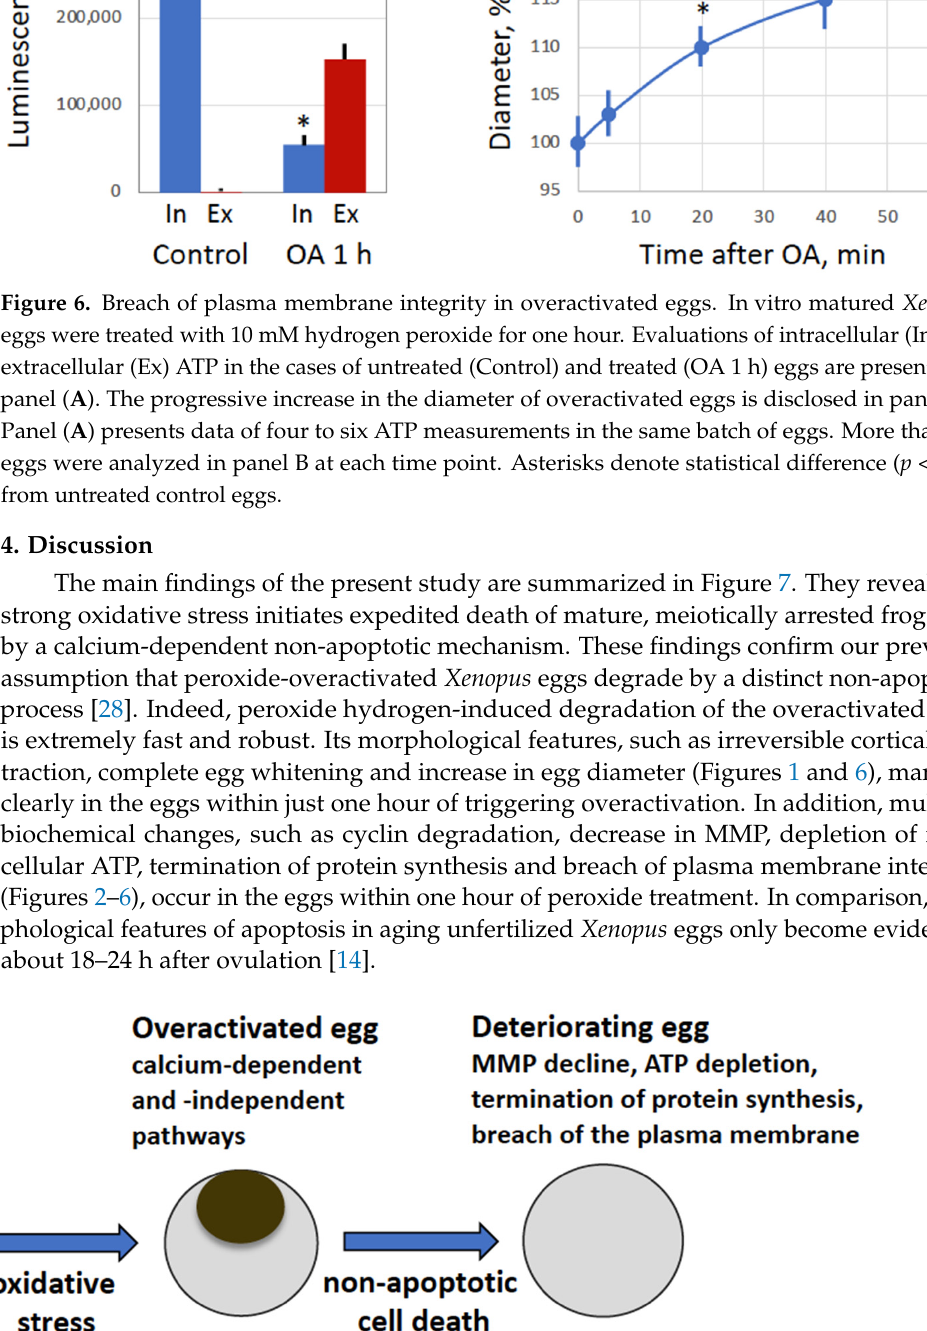
Figure 7. Oxidative stress ‐ induced overactivation and deterioration of frog eggs. Strong oxidative stress triggers overactivation and cell death of mature metaphase II ‐ arrested eggs of Xenopus laevis by a calcium ‐ dependent non ‐ apoptotic mechanism (see details in text).